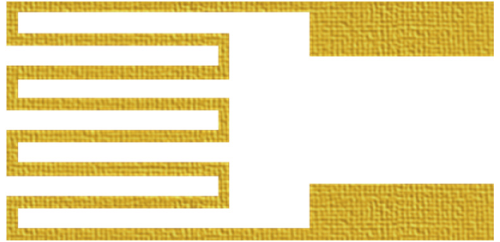
Figure 3. Schematic diagram of resistive micro temperature sensor.